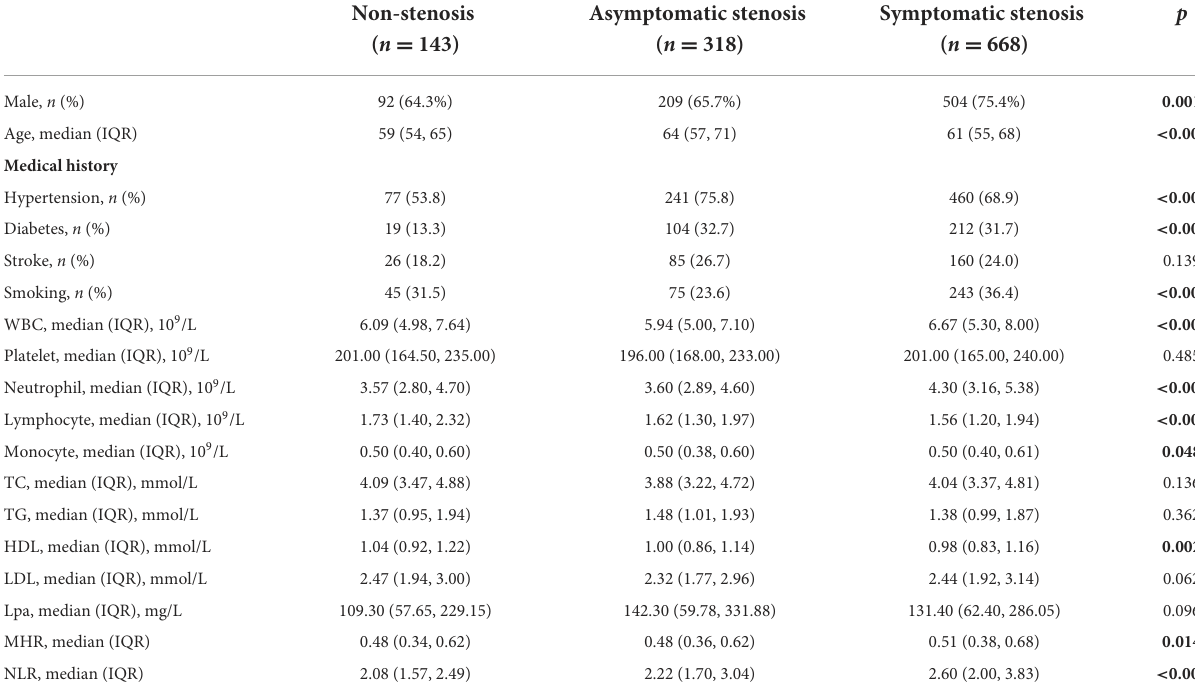
TABLE 3 Comparison of factors among the patients in the non-stenosis group, asymptomatic stenosis group and symptomatic stenosis group.